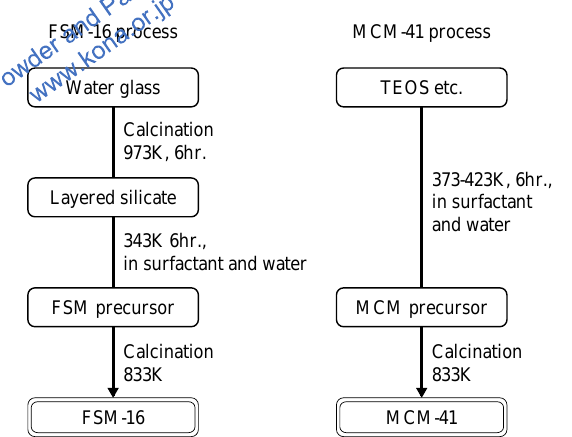
Schematic model of FMS-16 synthesis (modified from Inagaki